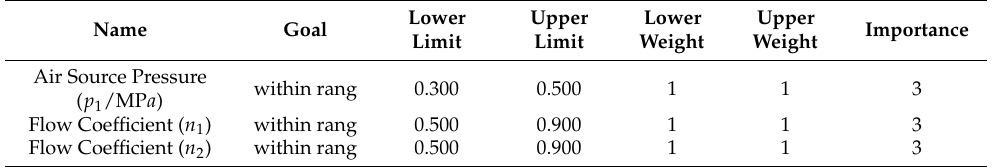
Table 7. Parameter optimization settings.